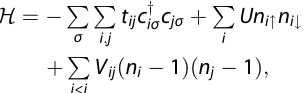
Fig. 1 Lattice structure of β 0 - X [Pd(dmit) 2 ] 2 . a Schematic triangular structure of β 0 - X [Pd(dmit) 2 ] 2 consisting of dimerized Pd(dmit) 2 molecules, where a Pd(dmit) 2 molecule is depicted as a long gray oval. b Modeled triangular lattice with three different electronic transfers. The strongest, middle and weakest transfers, t a (on the red bond ~ a ), t b (on the blue bond correspond to t B , t S, and t r , respectively in the literature 54 ). c Deformed structure on a L × L lattice with the system size N s = L 2 used in the present